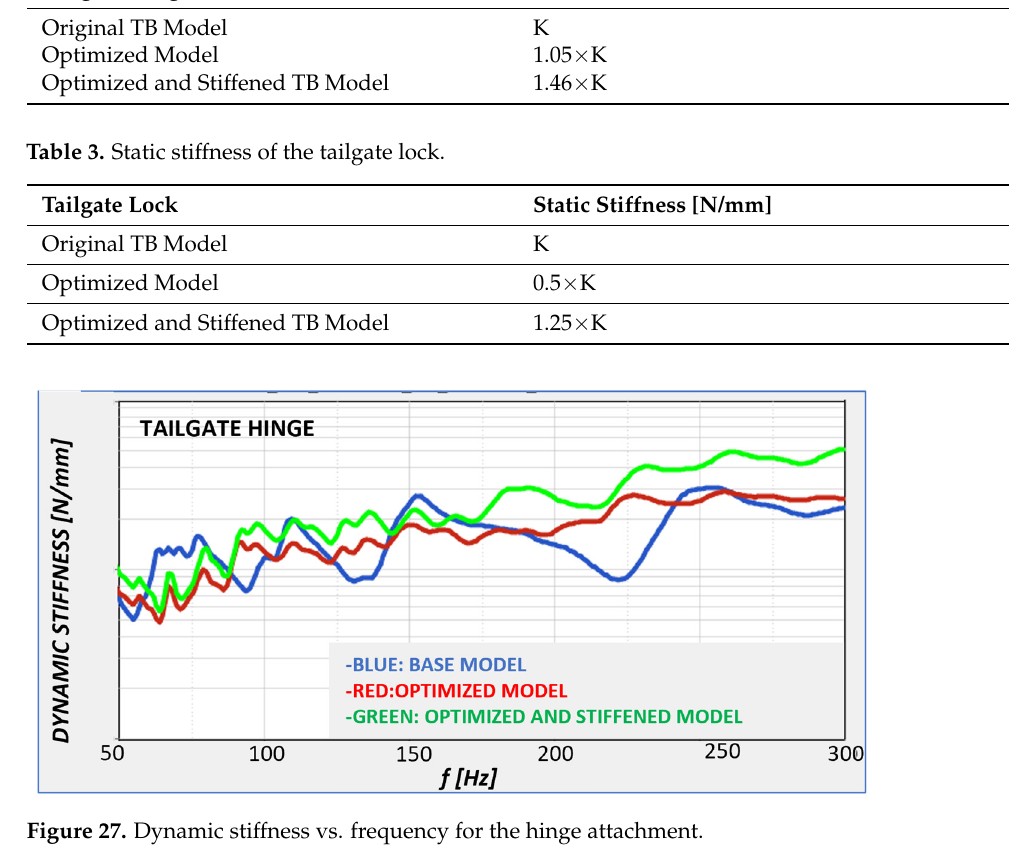
Figure 27. Dynamic stiffness vs. frequency for the hinge attachment.